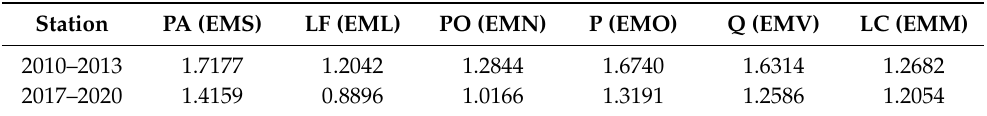
Table 2. Magnitude of the average wind speed and 2017–2020) and location.